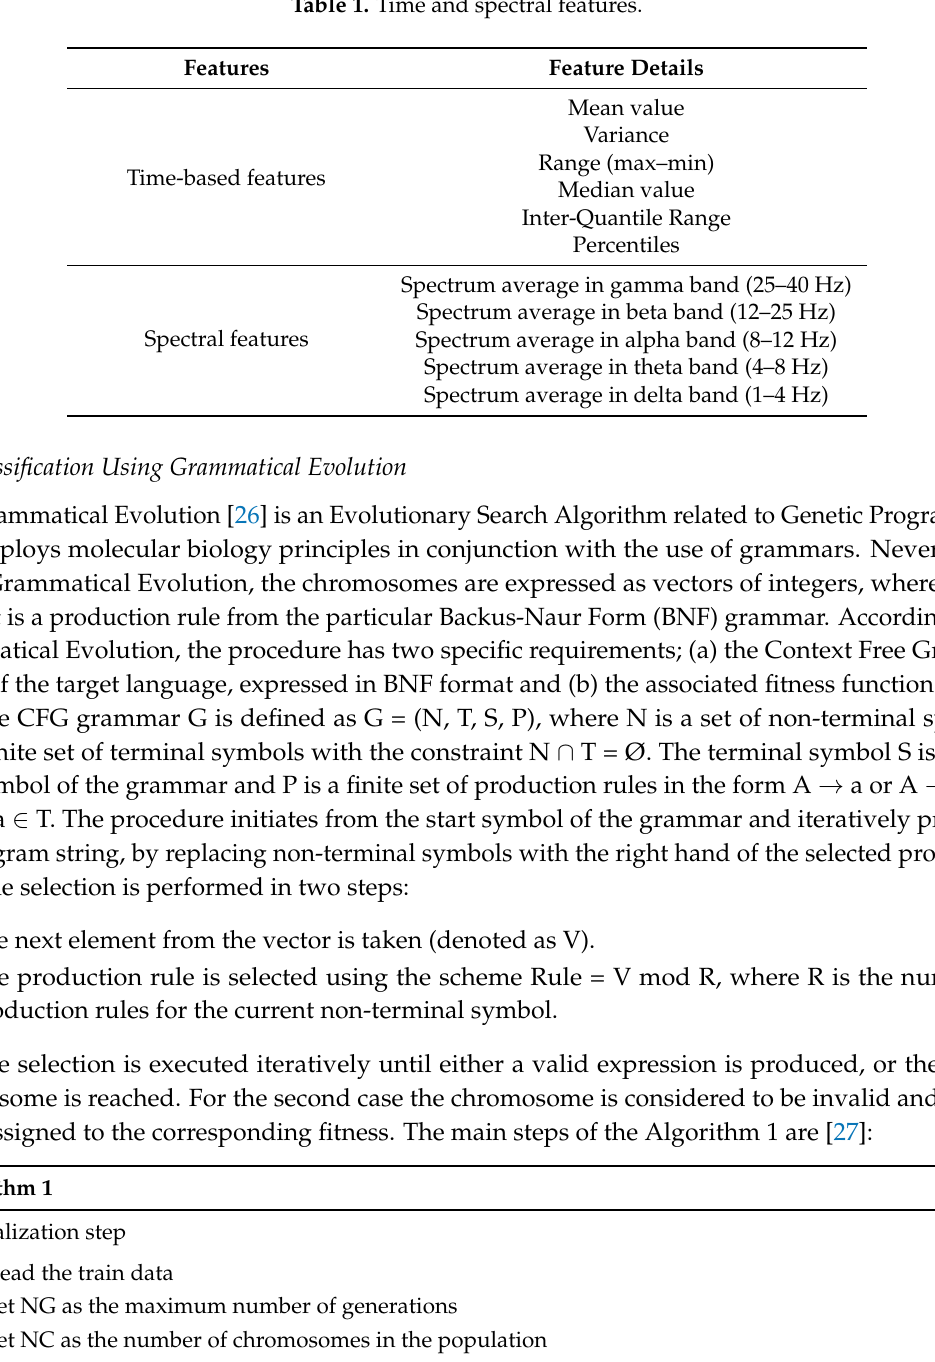
Table 1. Time and spectral